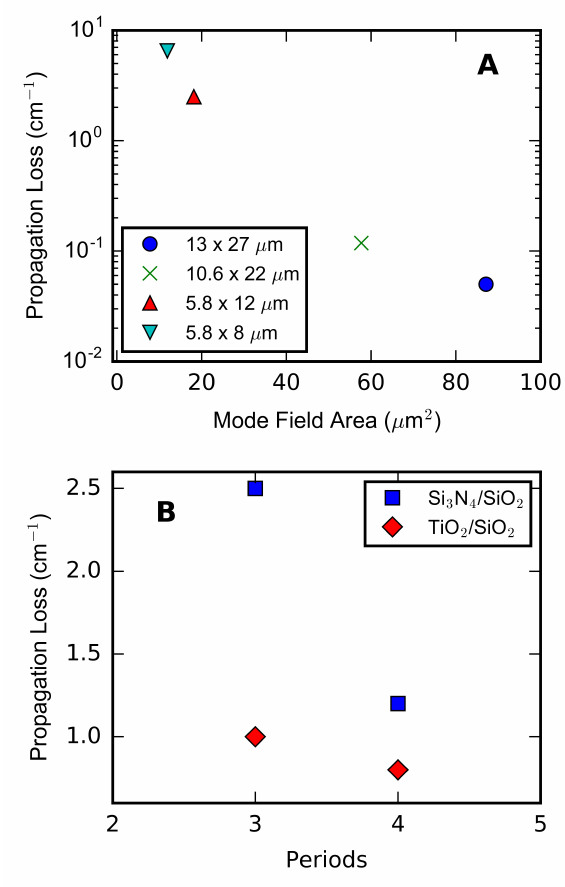
Fig. 4. (A) Plot of loss versus mode field area for a three-period SAP ARROW using Si 3 N 4 /SiO 2 layers for varying width and height. (B) Plot of loss versus number of periods of antiresonant layers for a similar ARROW as (A) for material combinations Si 3 N 4 /SiO 2 , where the refractive indices for Si 3 N 4 , TiO 2 and SiO 2 are 1.4, 2.4, and 1.44